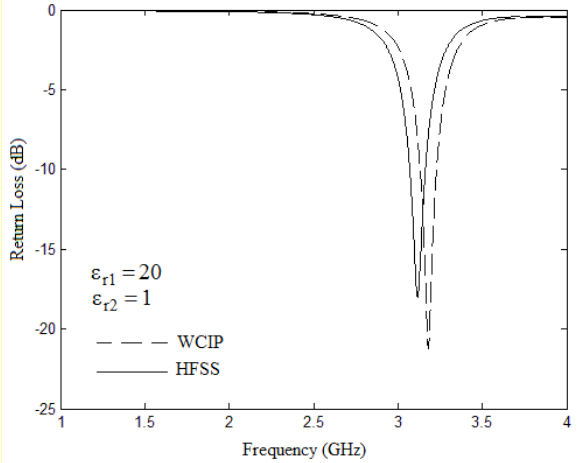
Figure 5: Return loss versus frequency for rectangular patch antenna on suspended nanostructured substrate.